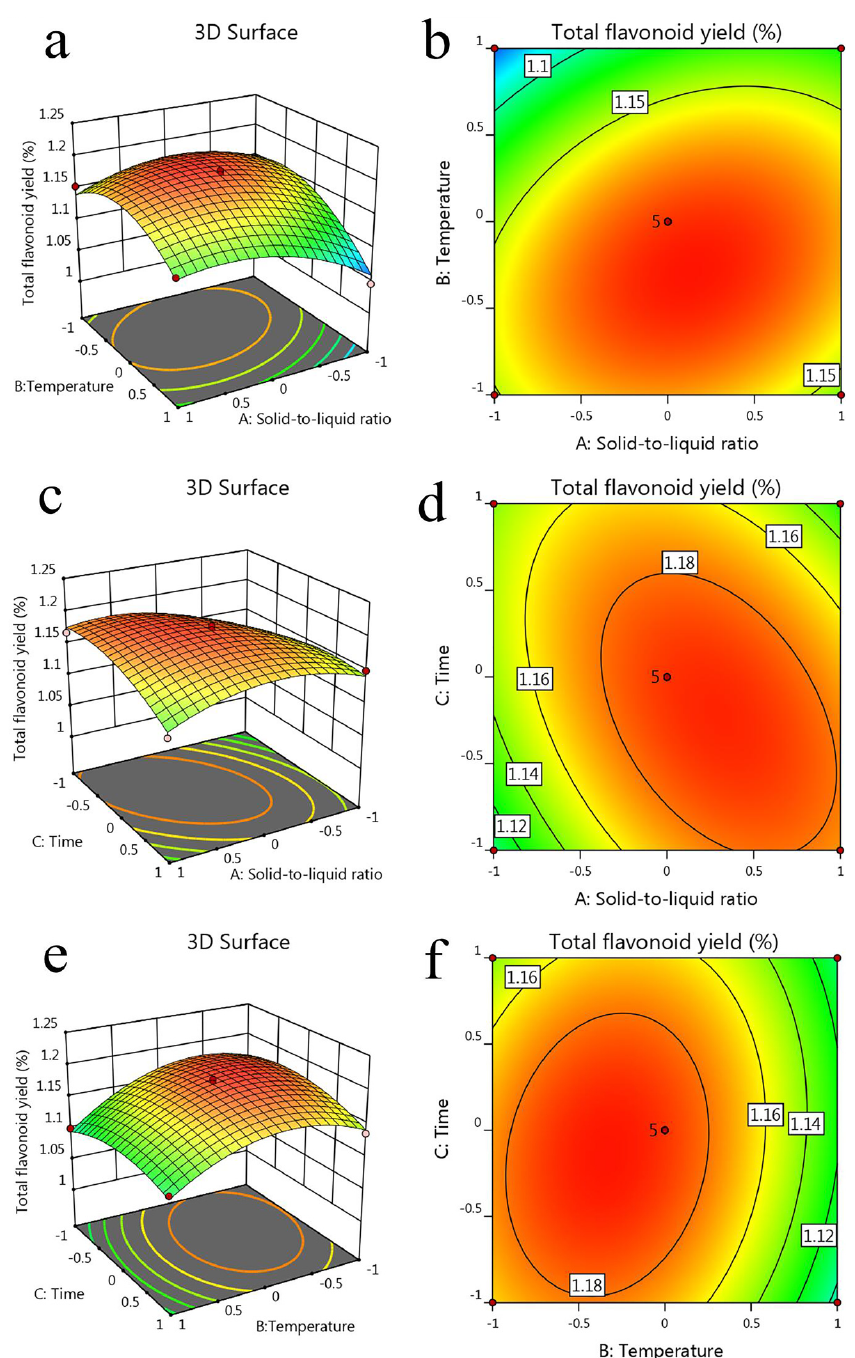
Figure 2. The diagrams of 3D surface for AB ( a ), AC ( c ) and BC ( e ) to total flavonoids yield. The diagrams of contour for AB ( b ), AC ( d ) and BC ( f ) to total flavonoids yield.